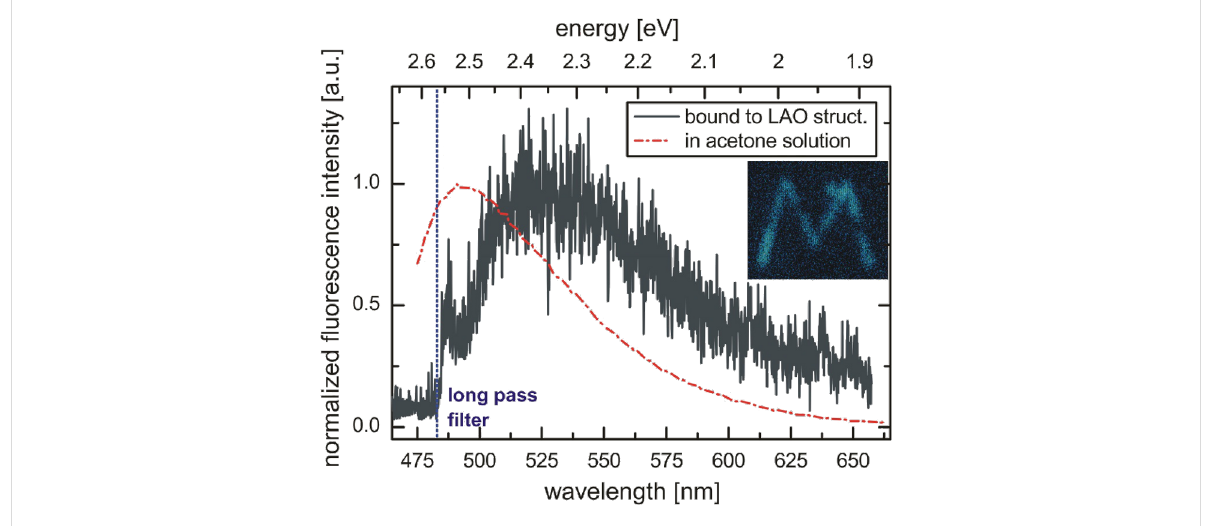
Figure 6: Fluorescence spectrum from the FITC-functionalized LAO oxide nanostructure shown in Figure 5 (dark grey curve) compared to FITC fluo- rescence in acetone solution (red dashed curve). The inset shows a confocal microscope image of the structure (excitation wavelength: 465 nm, exci- tation power: 11 μ W, integration time: 1 ms/px).